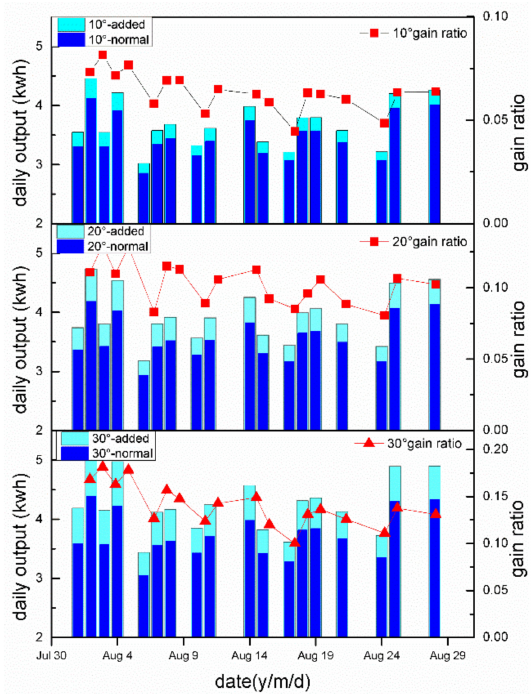
Figure 13. Comparison of the power generation and light gain of the prototype bifacial companion system in August before and after light supplementation.